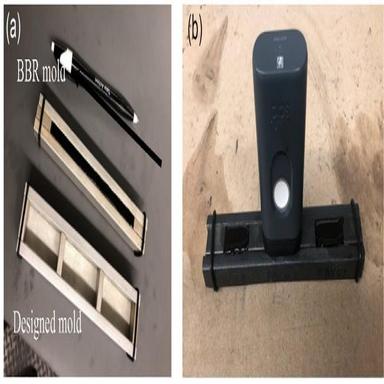
(a). Comparing the designed and the BBR molds, (b) SCiO light shield and sensor placed over molded, rectangular binder sample.